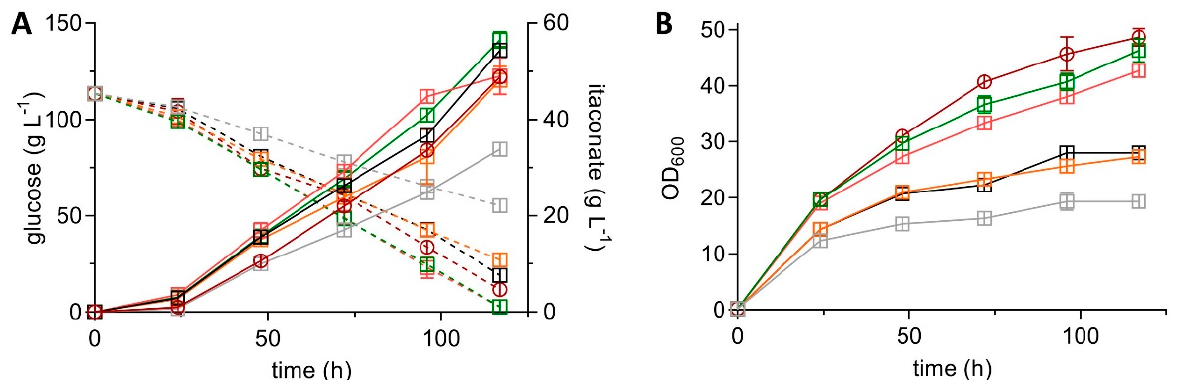
Figure 3. System Duetz ® cultivation of six U. maydis MB215 mutants in MTM with 100 g L − 1 glucose and 66 g L − 1 CaCO 3 , incubated in 24-well plates with a filling volume of 1.5 mL (shaking diameter = 50 mm, n = 300 rpm, T = 30 °C and Φ = 80%). Concentrations of itaconate (continuous lines) and glucose (dotted lines) ( A ) are shown, as well as OD 600 ( B ) of U. maydis MB215 ∆ cyp3 ∆ MEL ∆ UA ∆ dgat ∆ P ria1 :: P etef ∆ fuz7 (red) and five P etef mttA transformants U. maydis MB215 ∆ cyp3 ∆ MEL ∆ UA ∆ dgat ∆ P ria1 :: P etef ∆ fuz7 P etef mttA , K3 (grey), K8 (green), K9 (orange), K10 (pink), and K14 (black). Error bars indicate the standard error of the mean ( n = 3).